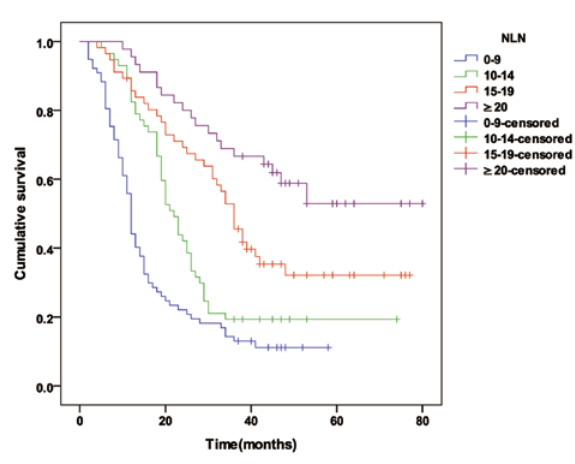
Figure 1: The overall survival curve for all patients with 9 or less, 10 to 14, 15 to 19 and 20 or more NLNs